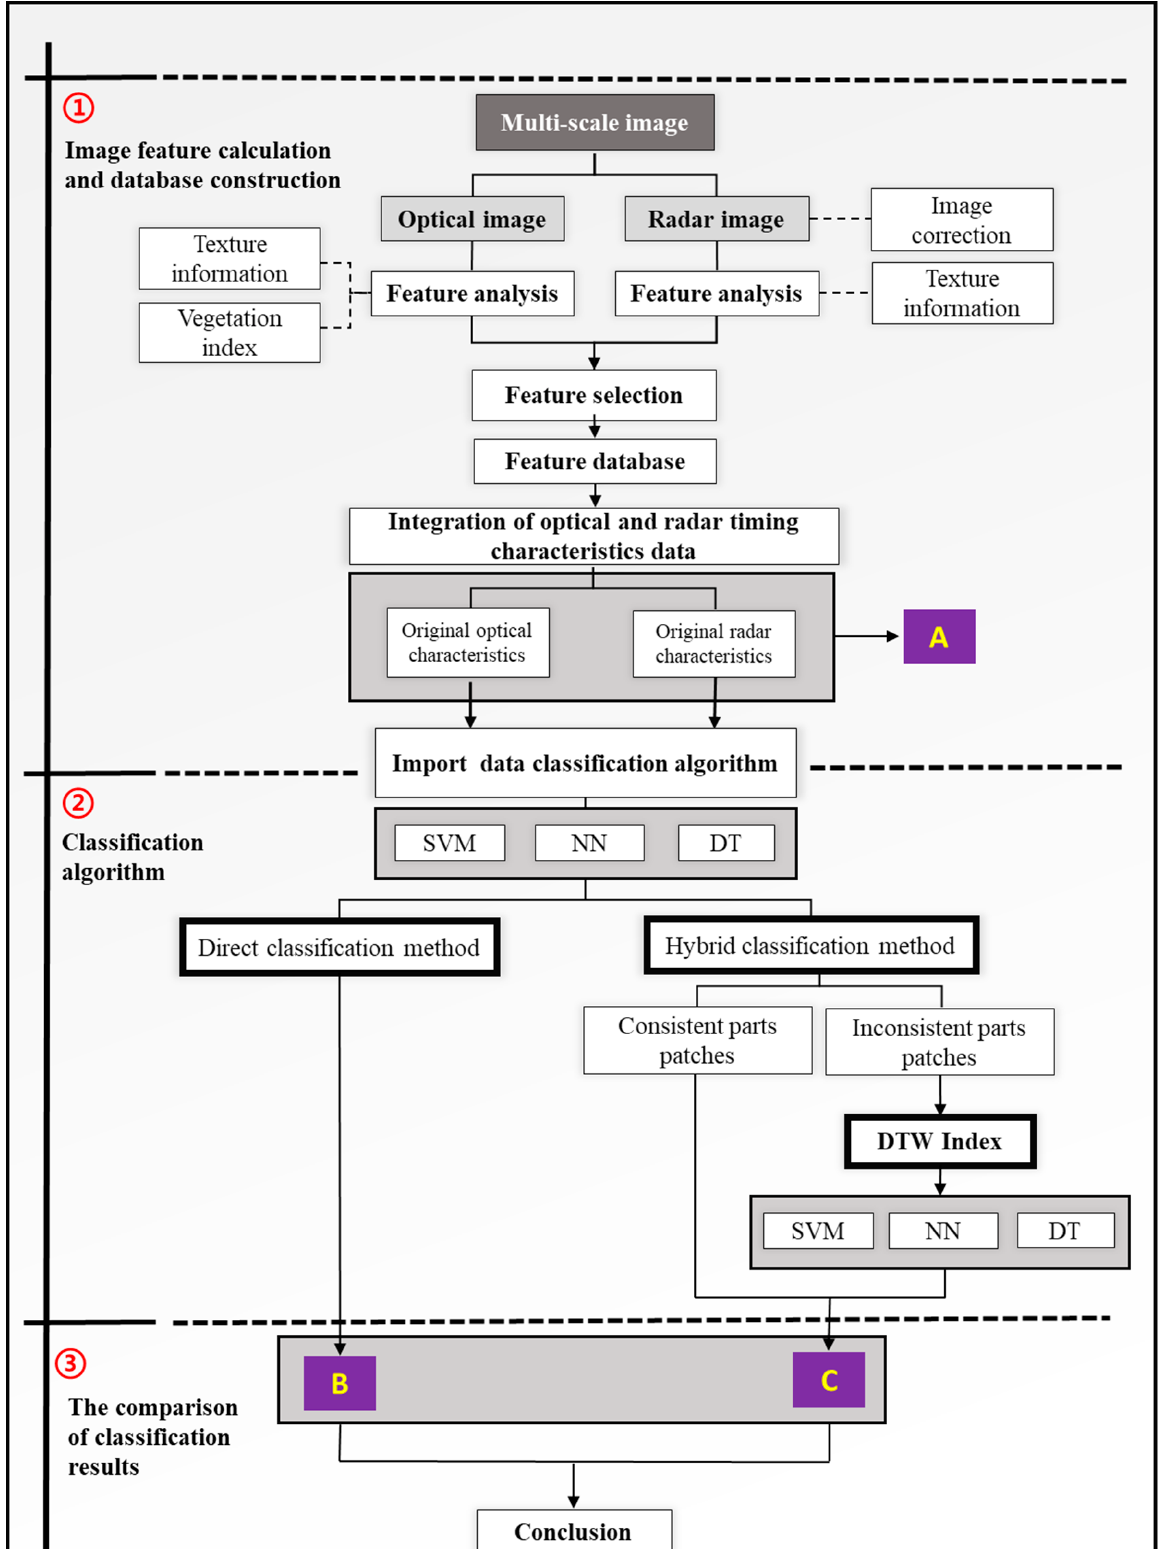
Figure 4. Steps for this study. 1. Image feature calculation and dataset construction: In the optical image part, in ad- dition to the four basic bands of red light (Red), green light (Green), blue light (Blue), and near-infrared light (NIR), this research included Ratio Vegetation Index (RVI) and Normalized Difference Vegetation Index (NDVI) and four Co-occurrence matrix (Gray Level Co-Occurrence Matrix, GLCM) texture indexes, including Homogeneity,